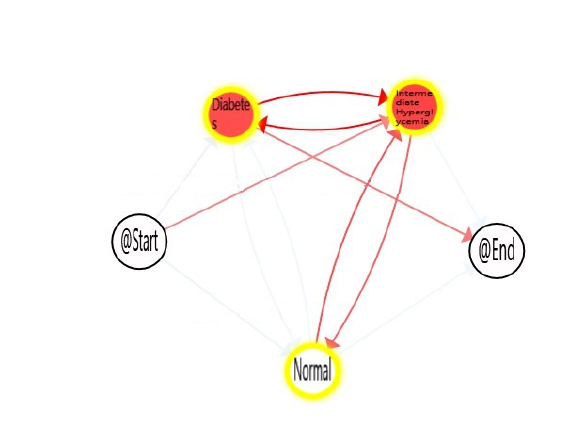
Figure 14. Differences between Young-Elderly